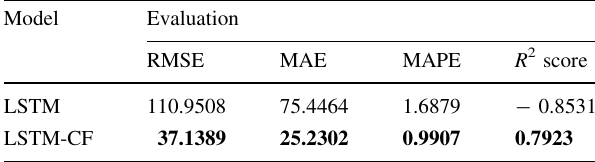
Table 4 The evaluation of prediction results of LSTM and LSTM-CF